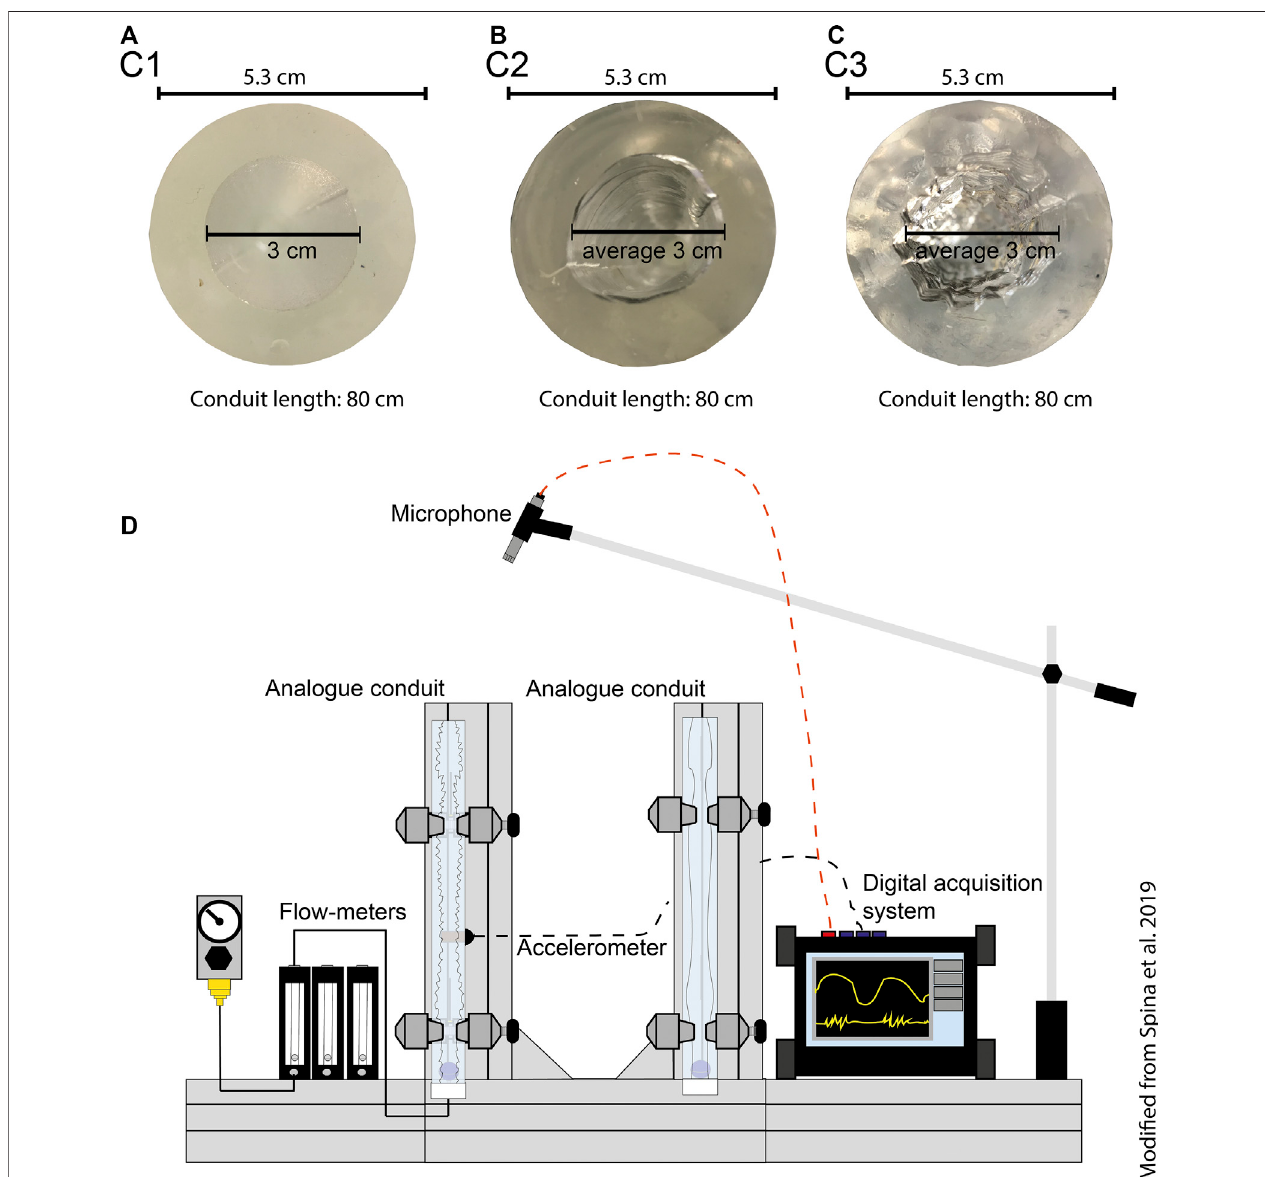
FIGURE 1 | (A – C) Top pictures of the analogue conduits SM (FD (cid:2) 2), F1 (FD (cid:2) 2.18) and F2 (FD (cid:2) 2.99), respectively. (D) Simpli fi ed sketch of the experimental device (not to scale; modi fi ed from Spina et al., 2019). The tubes shown in (D) are 80 cm high. Modi fi ed from Spina et al. (2019).